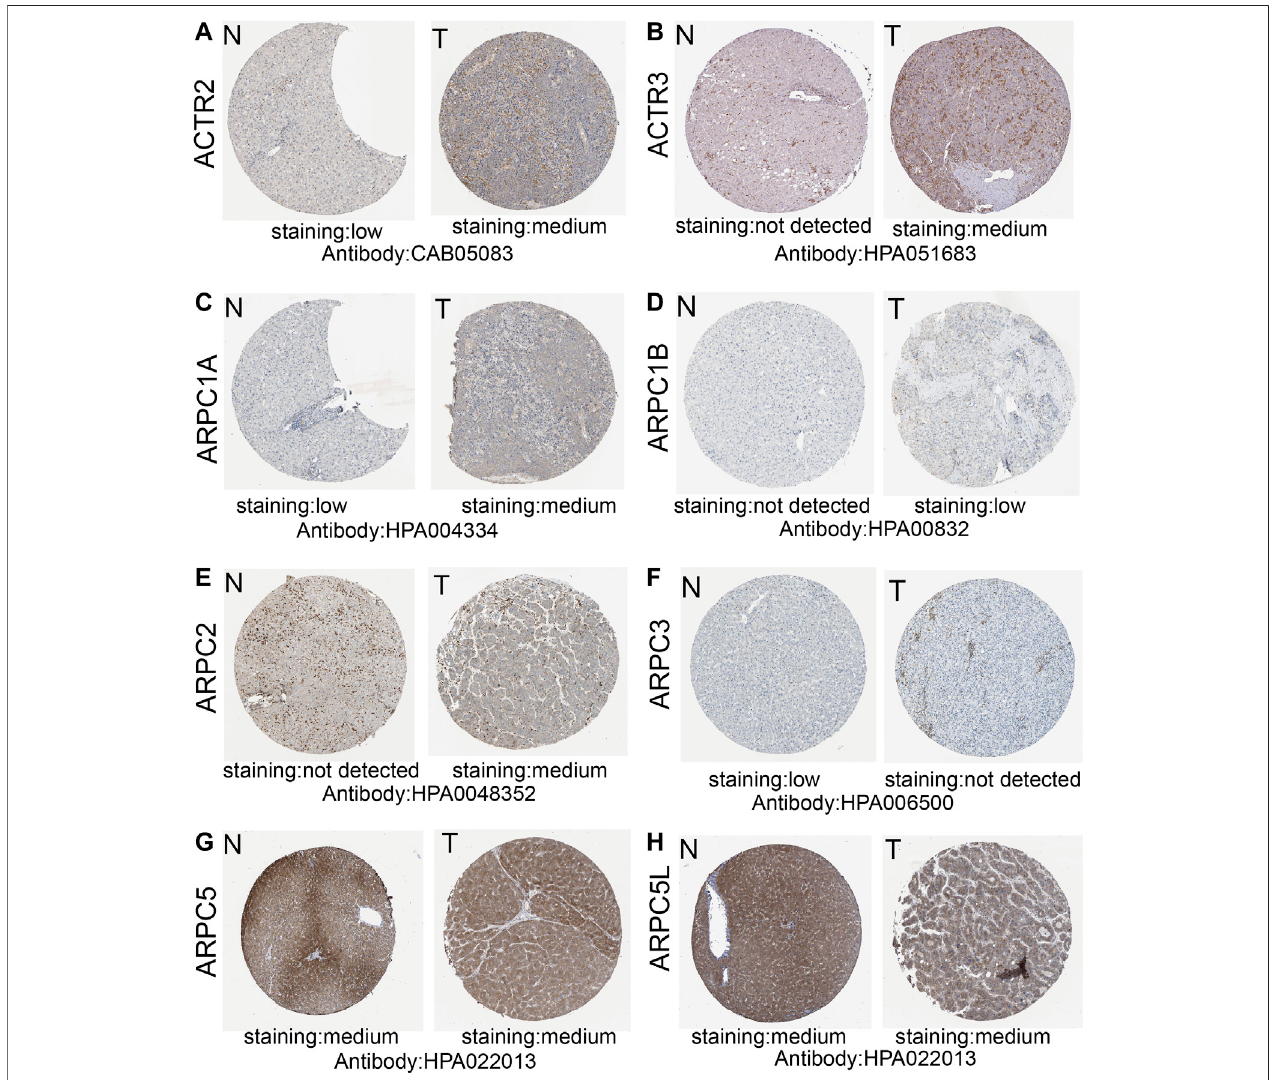
FIGURE 6 | Representative immunohistochemistry images of Arp2/3 members (except for ARPC4) of HCC tissues and normal liver tissues in the Human Protein Atlas (A – H) . T, HCC tissues; N, normal liver tissues.